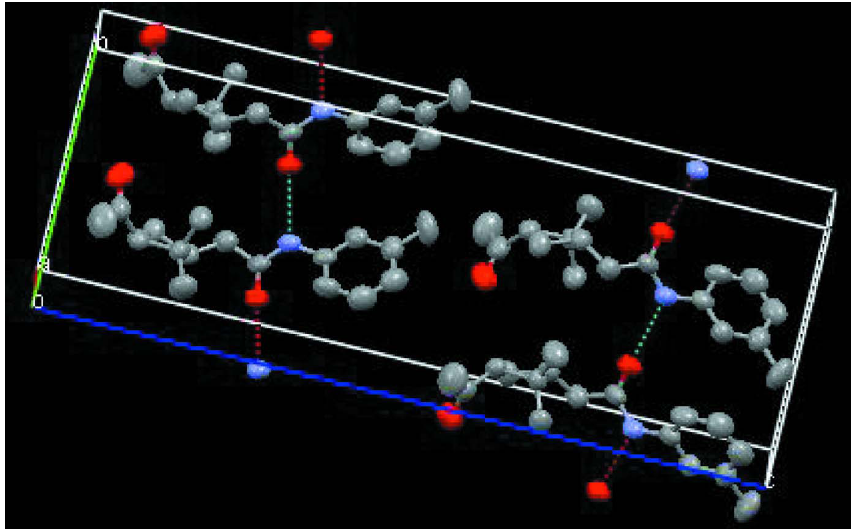
A view of the molecular structure of (I), showing displacement ellipsoids at the 50% probability level.